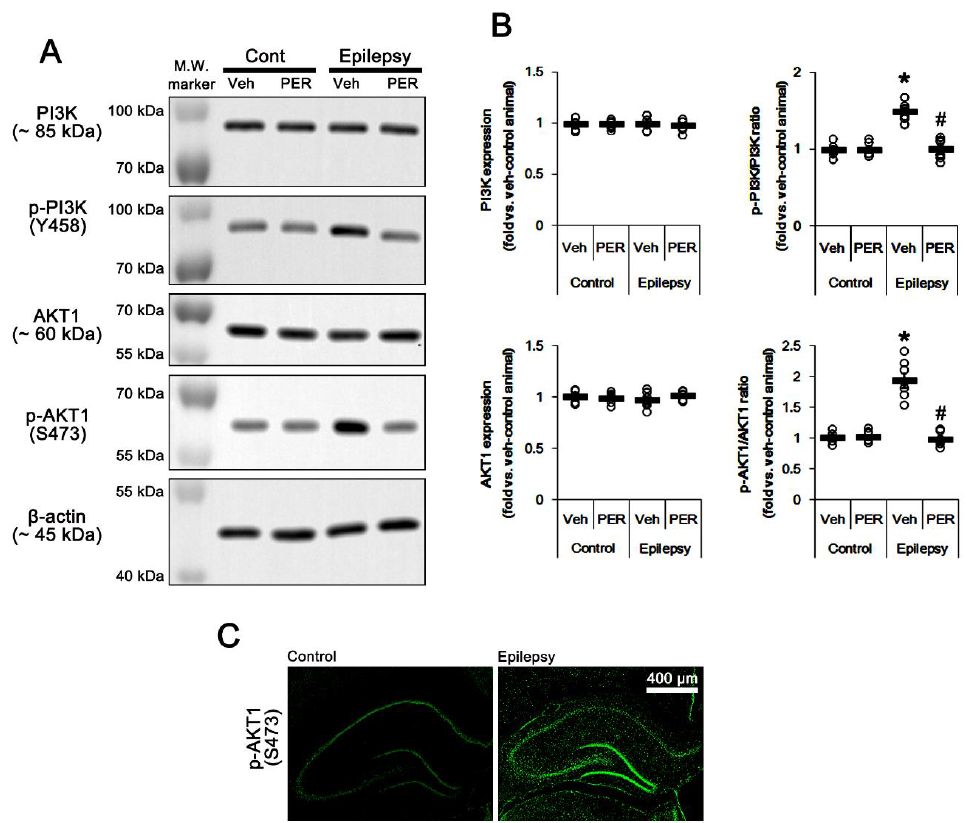
Figure 3. The effect of perampanel (PER) on phosphoinositide 3-kinase (PI3K) and AKT1 expressions and their phosphorylations in control (cont) and epileptic rats. ( A ) Representative images for Western blot of PI3K, phospho (p)-PI3K, AKT1, and p-AKT1 level in the hippocampal tissues. ( B ) Quantifications of PI3K, phospho (p)-PI3K, AKT1, and p-AKT1 level in the hippocampal tissues. Open circles indicate each individual value. Horizontal bars indicate mean value. Error bars indicate SEM (*, # p < 0.05 vs. vehicle (Veh)-treated control animal and vehicle-treated animals, respectively; one-way ANOVA with post hoc Bonferroni’s multiple comparison; n = 7, respectively). ( C ) Representative photos of p-AKT1 signals in the control and epileptic